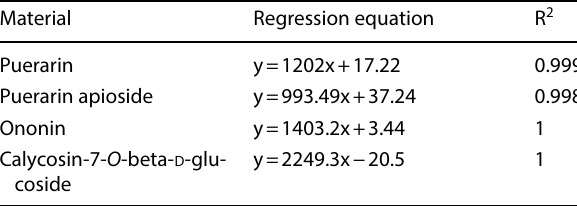
Fig. S2 Comparison of different extraction methods, Fig. S3 Comparison of different mobile phases, Fig. S4 Compari- son of different flow rate, Fig. S5 Comparison of different wave length, Fig. S6 Methodology investigation, Fig. S7 Pattern of positive and negative ions in samples, Fig. S8 Mass spectra of 9 standard products, Fig. S9 linear regres- sion curve, Table S1 Retention time of stability test (n = 5), Table S2 Peak area of stability test (n = 5), Table S3 Reten- tion time of precision test (n = 5), Table S4 Peak area of pre- cision test (n = 5), Table S5 Retention time of repeatability test (n = 5), Table S6 Peak area of repeatability test (n = 5), Table S7 Similarity Matching Results of the HPLC Finger- print of the AAF, Table S8 Retention time of mutual peaks, Table S9 Peak area of mutual peaks, Table S10Normalized results of relative peak area, Table S11 Setting of screening parameters, Table S12 Parameters of LC–MS, Table S13 9 Parameters of LC–MS, Table S14 Result of content deter- mination, Table S15 Parameters of LC–MS in references, Table S16 Sample Information.